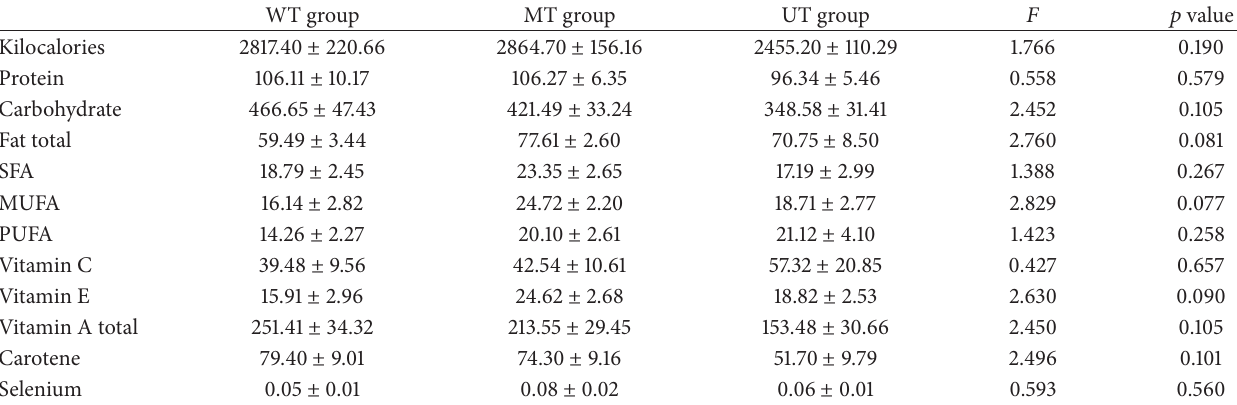
Table 3: Dietary intake assessment during the 3-day period prior to the main trial.